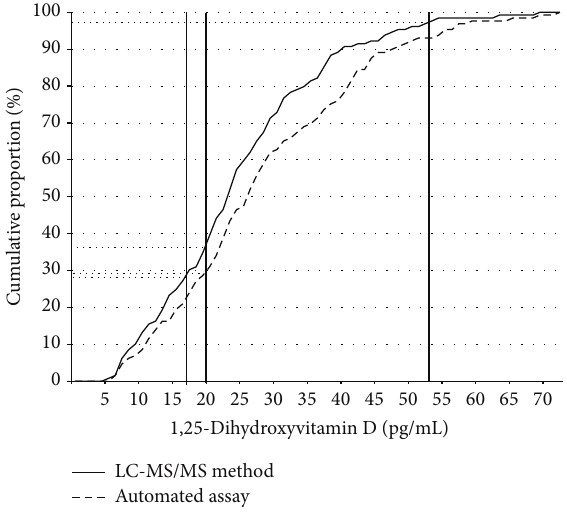
Figure 2: Ogive showing the percentage of specimen with 1,25- dihydroxyvitamin D concentrations below a certain value according to test procedure. The vertical lines mark different cut-off levels for deficient or harmful 1,25-dihydroxyvitamin D concentrations.